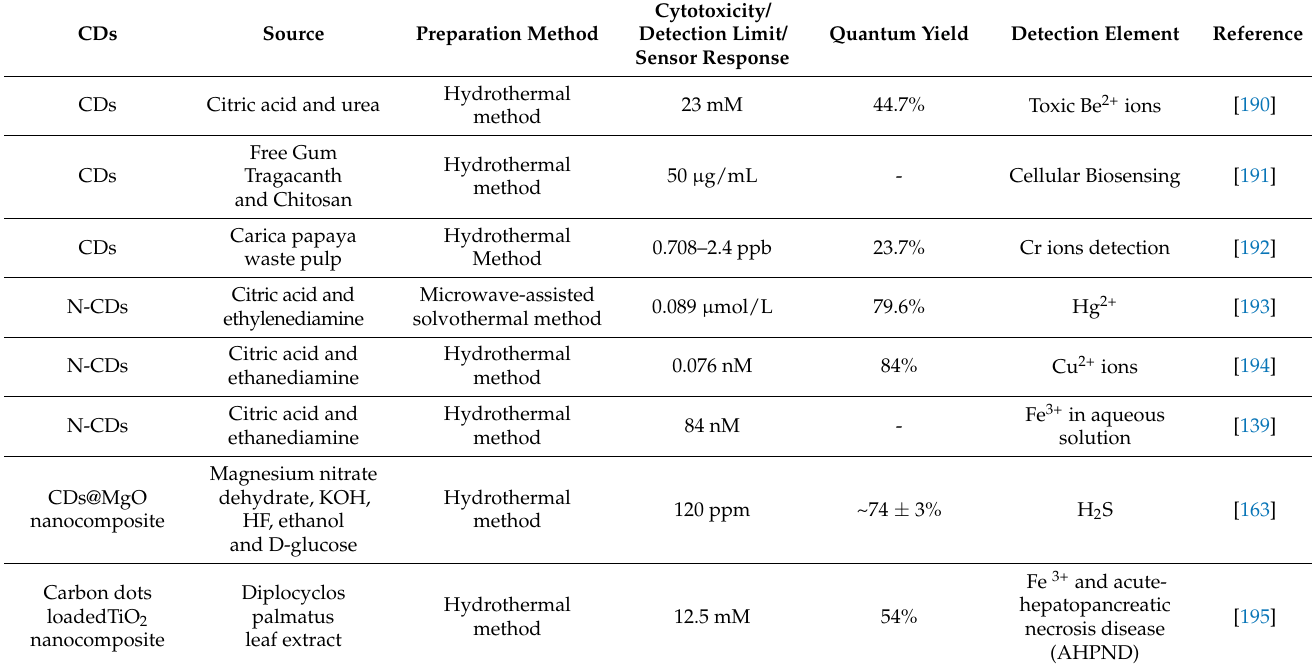
Table 2. Synthesis routes, source, and cytotoxicity of CDs, N-CDs, and CDs